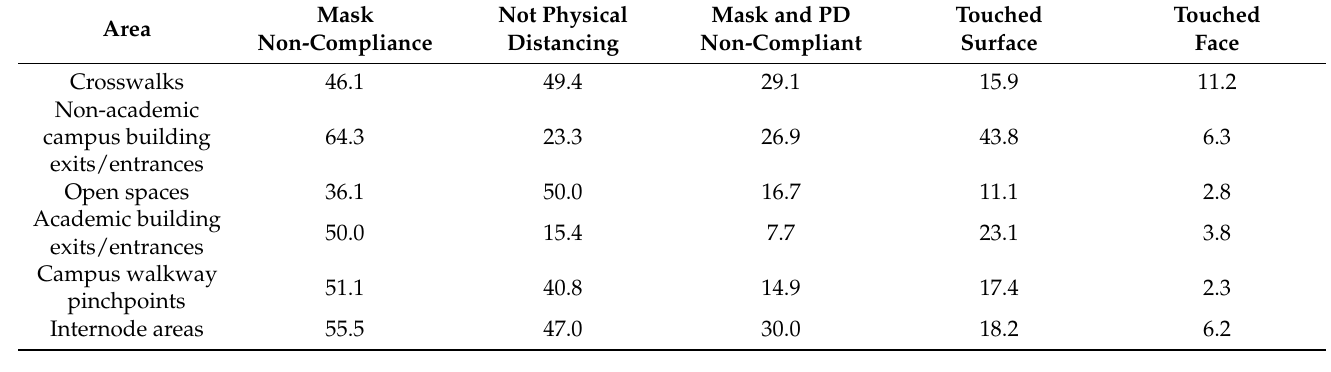
Table 7. COVID-19 transmission behaviors by specific place of observation.